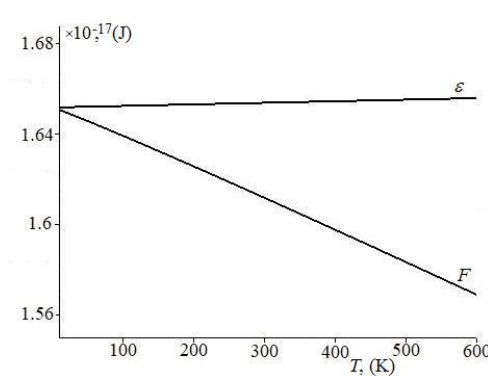
Fig.3. Free energy F and average energy ε of ensemble of kinks of plasmid